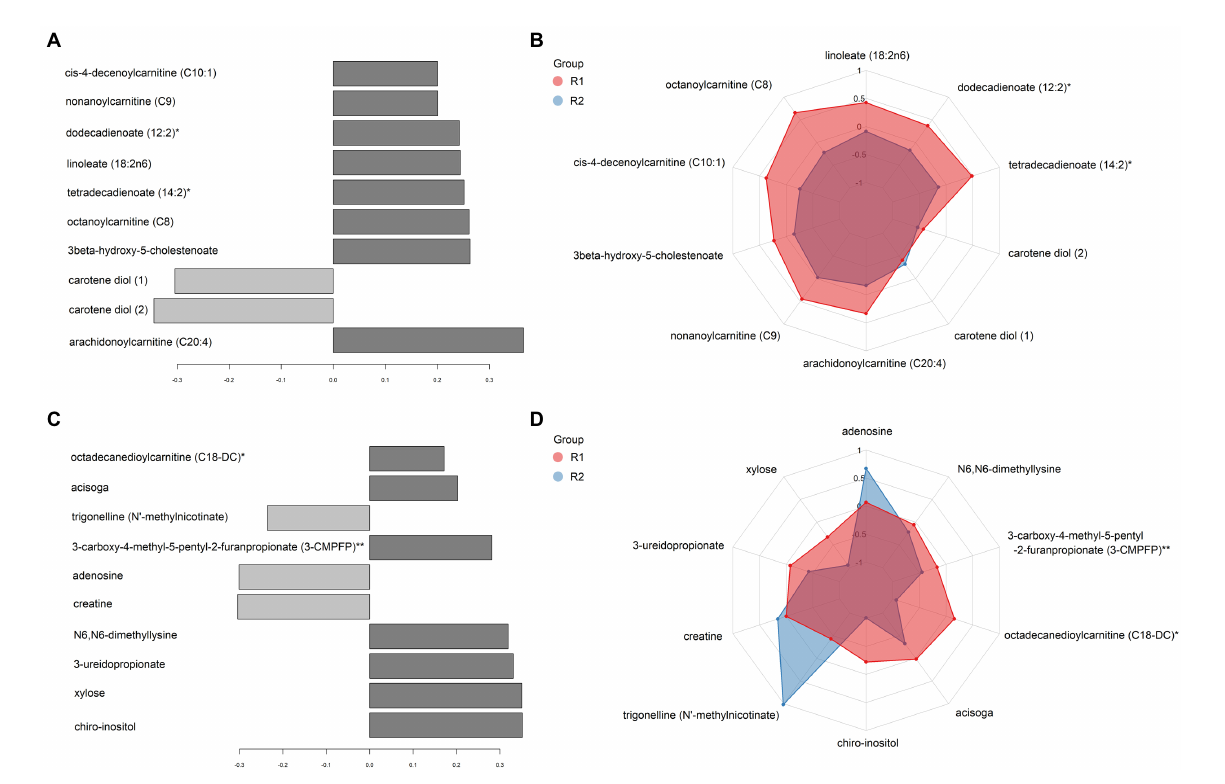
FIGURE 3 Most discriminant metabolites between type 1 and type 2 responder groups. Panels (A) and (C) show the ten most discriminant metabolites of component 1 and component 2 of the sparse partial least squares discriminant analysis (sPLS-DA) respectively, ordered from bottom to top by highest loading weight in the discrimination in their respective component. Negative loading weights are shown in light gray and positive loading weights are shown in dark gray. Panels (B) and (D) show the magnitude of change in metabolite levels for the top ten metabolites in component 1 and component 2 for each response subgroup. Changes for type 1 responders are shown in red and changes for type 2 responders are shown in